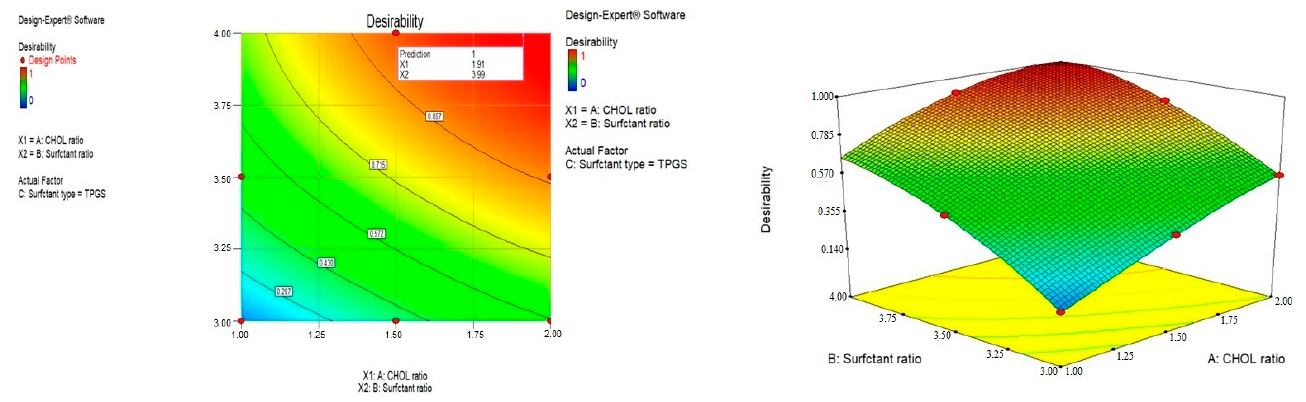
Figure 3. Optimization of the prepared drug-free niosomes.